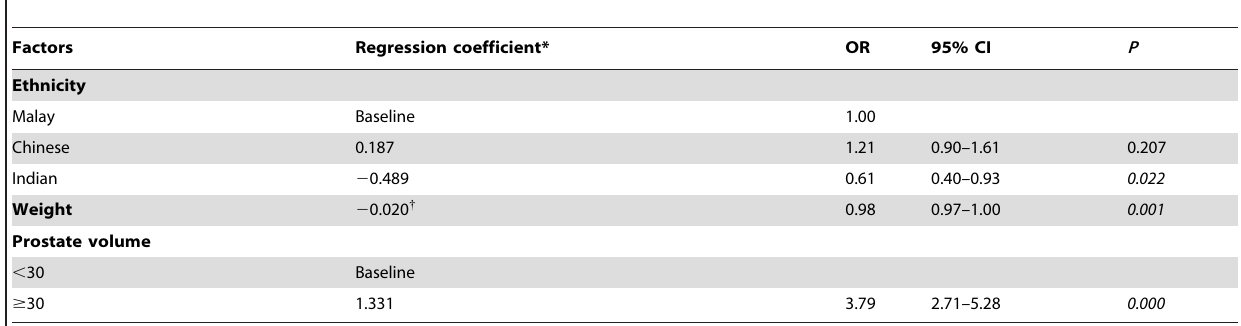
Table 4. Multivariable analysis of factors associated with age-specific median PSA